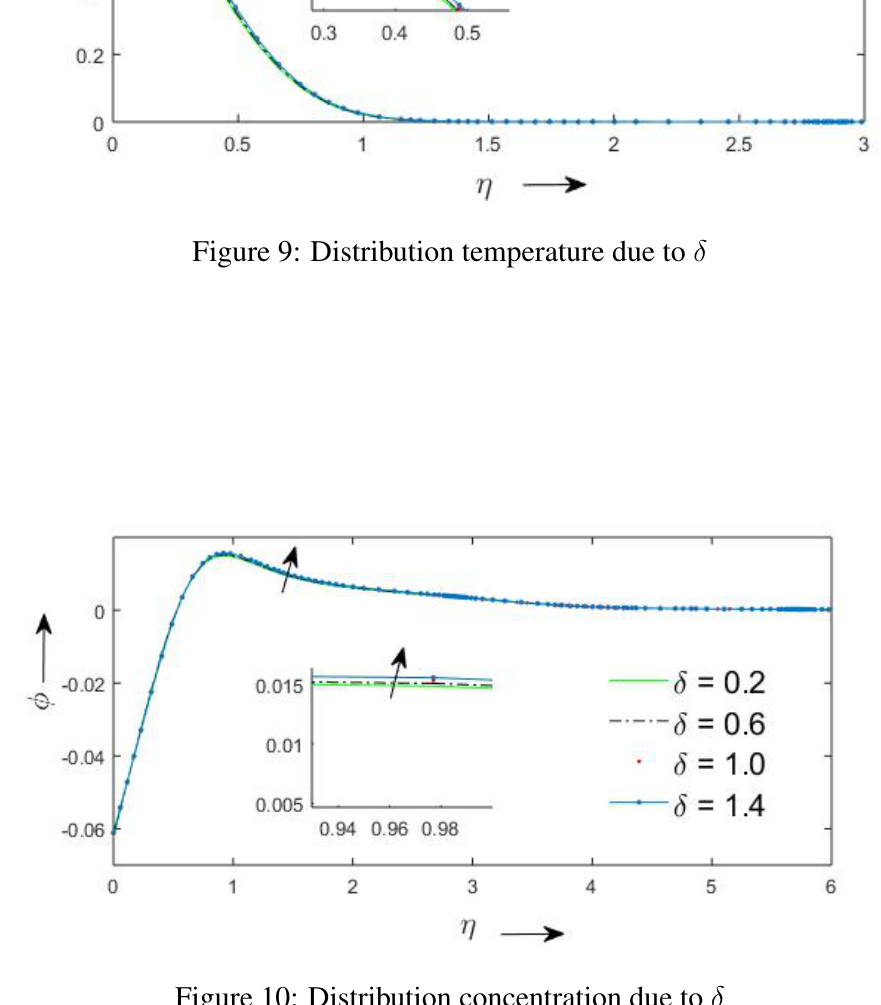
Figure 10: Distribution concentration due to